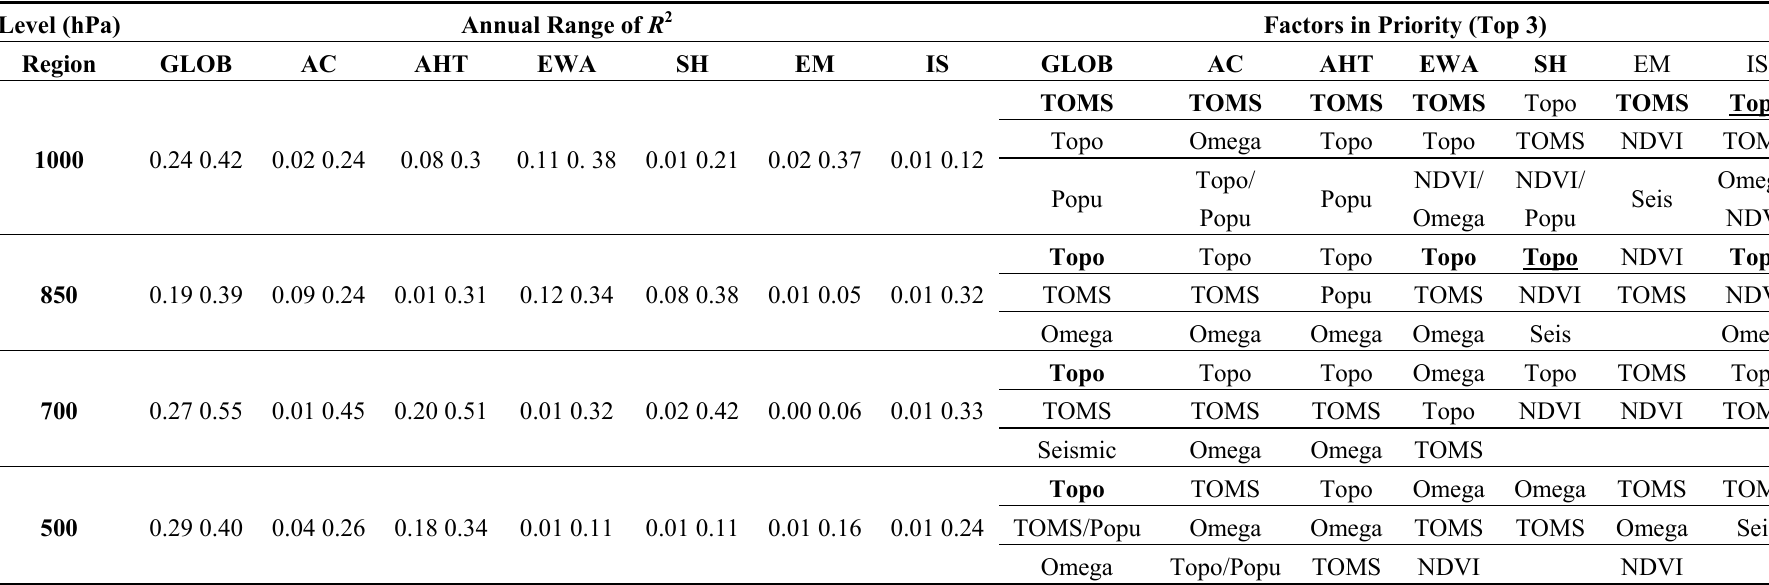
Table 3. Qualitative summary of the multi-regression results for the different research regions. Bold: absolute dominant variable in the annual course. The yellow marking indicates a negative coefficient